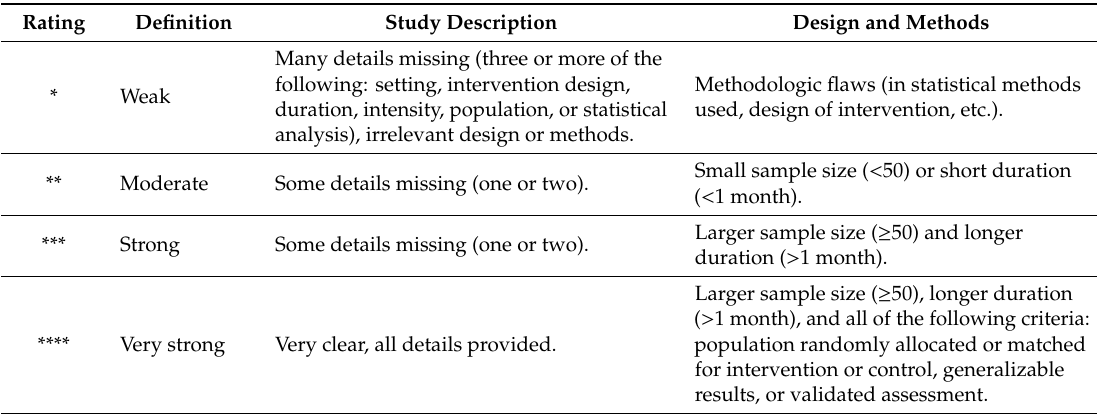
Table 2. Quality assessment (QA) of studies included in the